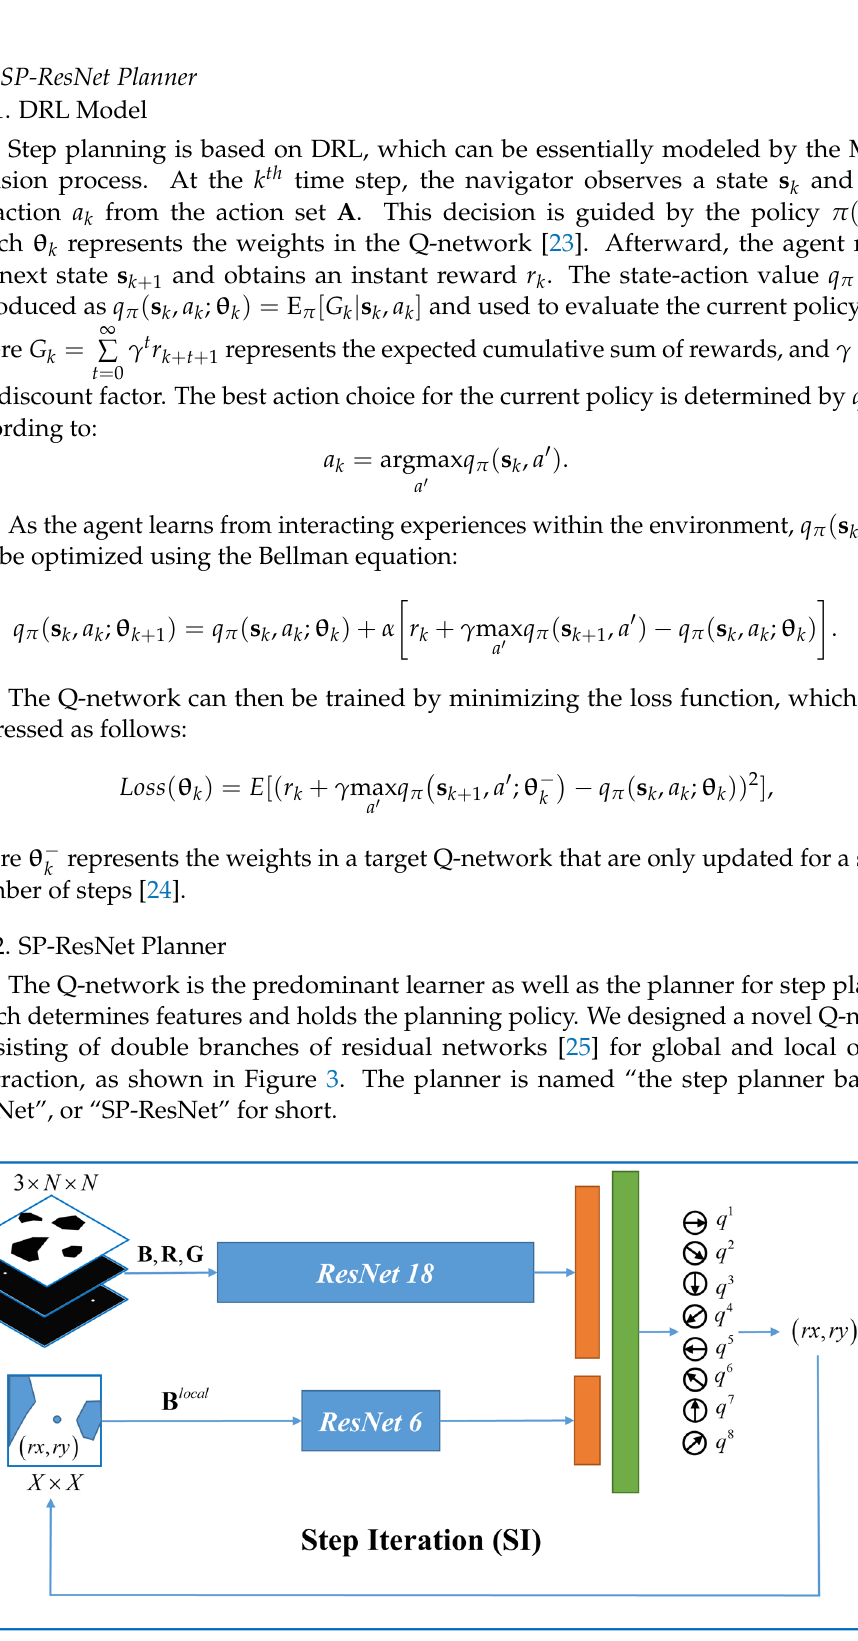
Table 1. The step iteration by the SP-ResNet planner. Step Iteration (SI) a.